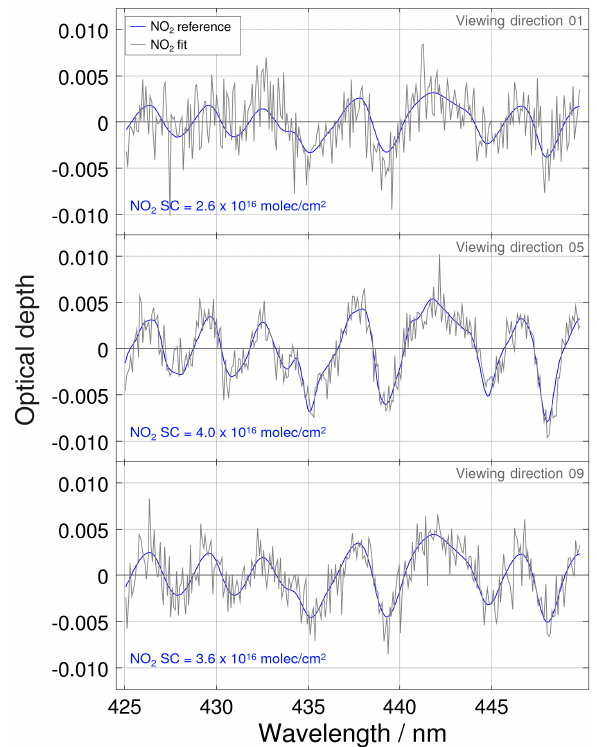
Figure 7. Example NO 2 fit results for 4 June 2011, 10:11:47UTC, for three of the nine different viewing directions, VD01, VD05 and VD09. The respective NO 2 slant columns are given in the figures.